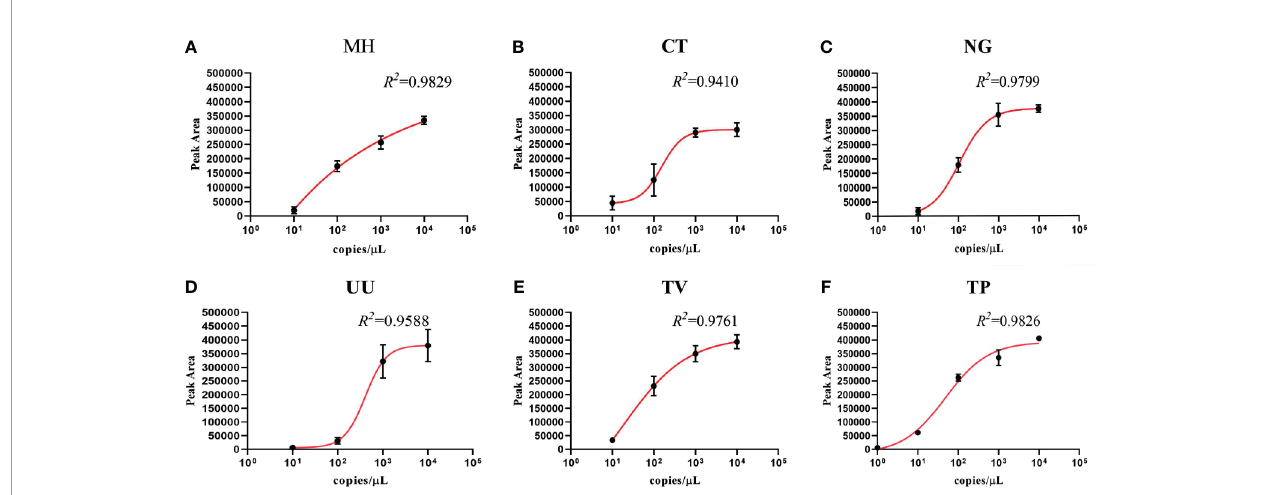
FIGURE 4 | The detection of six pathogens from corresponding plasmids showing the quantitative standard curves obtained by 10-fold dilutions of the DNA template from 1 to 10 4 copies/µL (x-axis) and their corresponding sexually transmitted infections high-throughput multiplex gene detection system (STI-HMGS) peak areas (y-axis). Each concentration was tested on three independent occasions using the STI-HMGS assay. Error bars are not shown if they are shorter than the size of the symbol used to indicate the mean value of the three peak areas. (A – F) Calibration curves for Mycoplasma hominis (MH) (R 2 = 0.9829), Chlamydia trachomatis (CT) (R 2 = 0.9410), Neisseria gonorrhoeae (NG) (R 2 = 0.9799), Ureaplasma urealyticumm (UU) (R 2 = 0.9588), Trichomonas vaginalis (TV) (R 2 = 0.9761) and Treponema pallidum (TP) (R 2 = 0.9826),